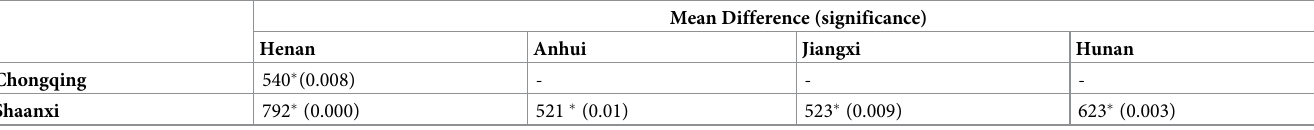
Table 3. The significant differences of NCCC between every two